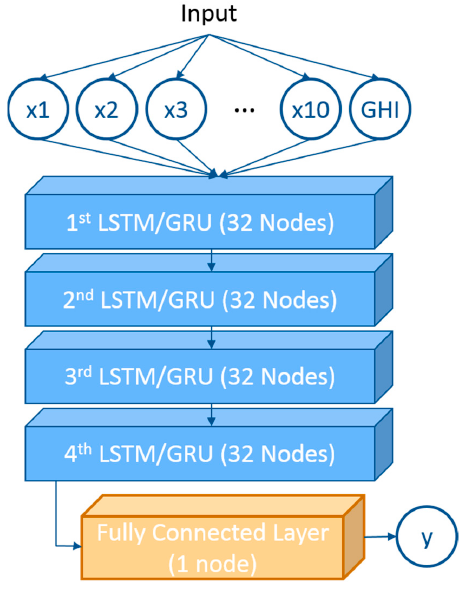
Figure 9. The LSTM/GRU model.